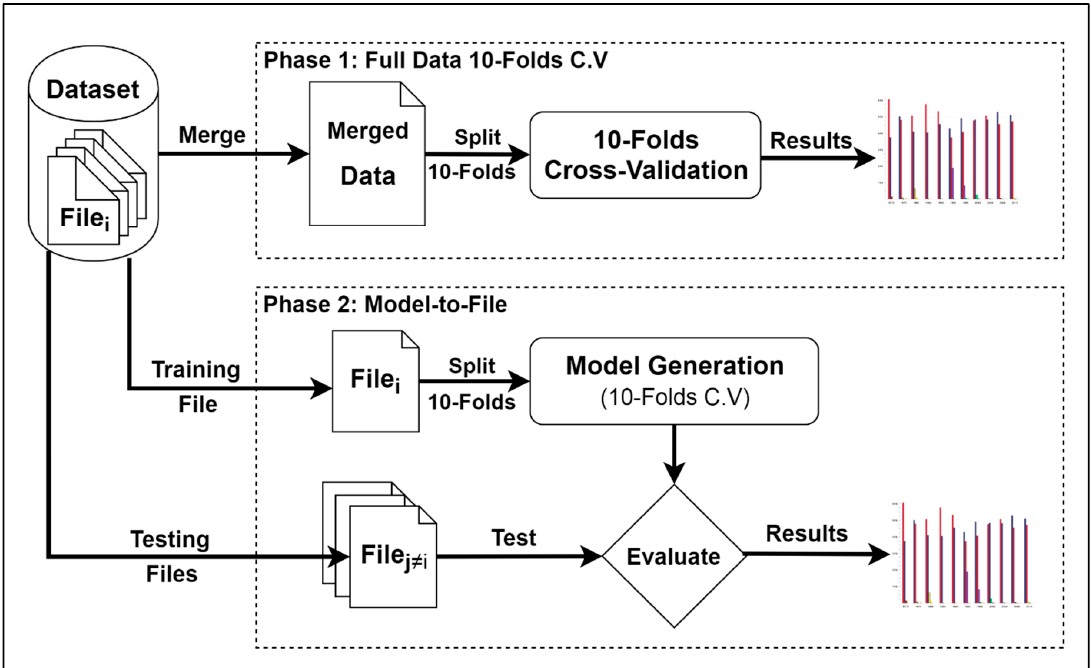
Figure 4. The phase diagram of the experiments.